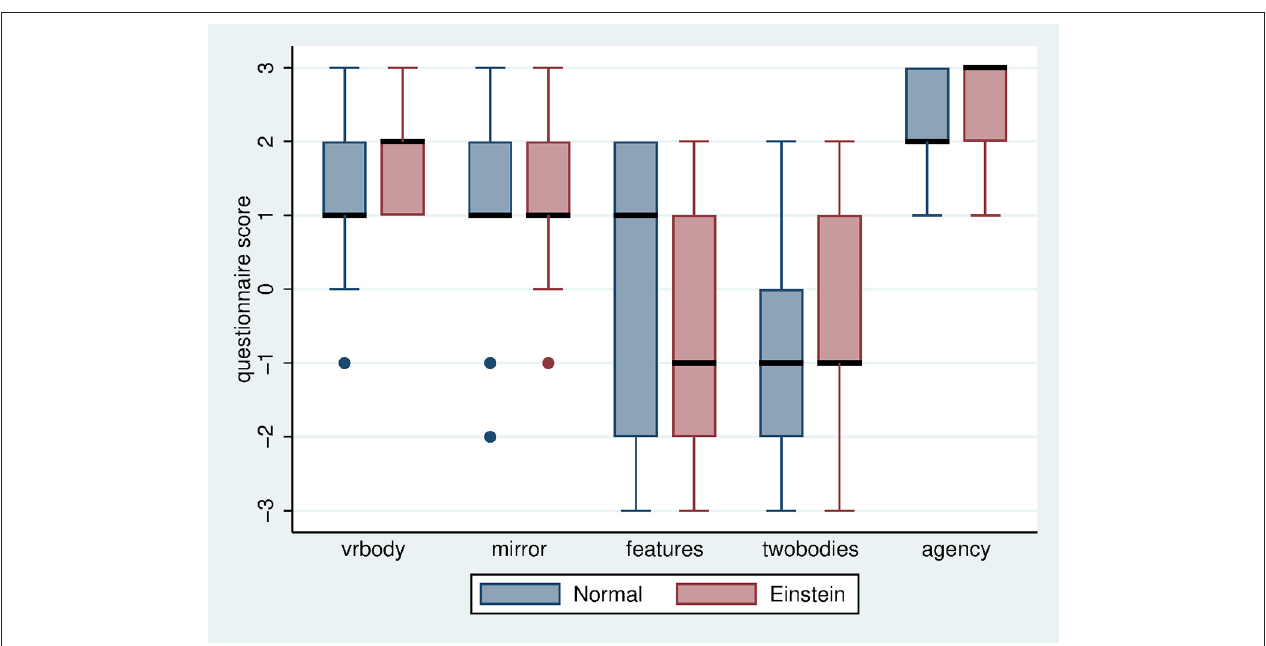
FIGURE 2 | Box plot of questionnaire scores on body ownership and agency. The horizontal thick lines are the medians, the boxes are the Interquartile Ranges (IQR), and the whiskers range from max (min value, lower quartile − 1.5*IQR) to min (max value, upper quartile + 1.5*IQR).